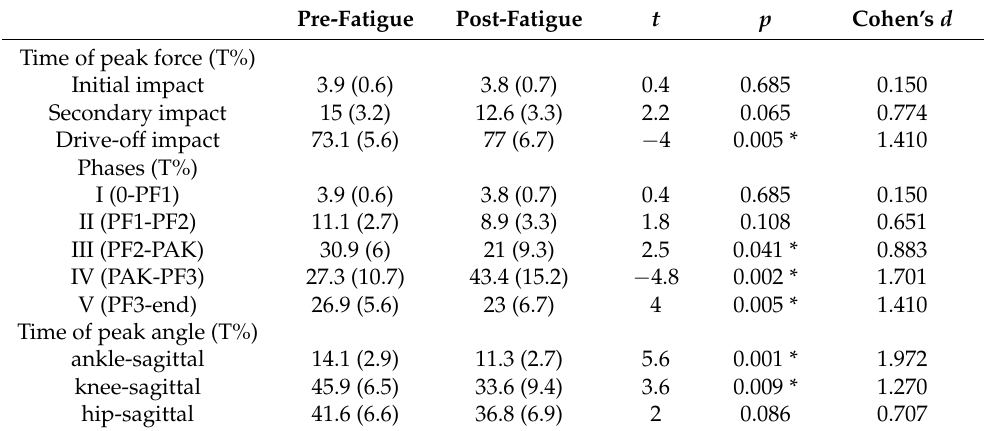
Table 1. Time of peak force (T%), sub-phases (T%) and time of peak angle (T%) (mean ± SD). Pre-Fatigue